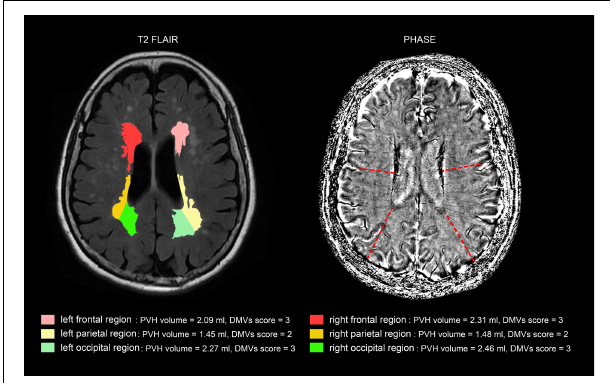
FIGURE 3 | An example of correlation between deep medullary veins (DMVs) and periventricular hyperintensities (PVHs) in different brain regions. The PVHs in the subject in frontal regions and occipital regions were relatively severe than that of parietal regions, and the DMVs scores in frontal regions and occipital regions (both grade 3) were higher than that of parietal regions (grade 2).